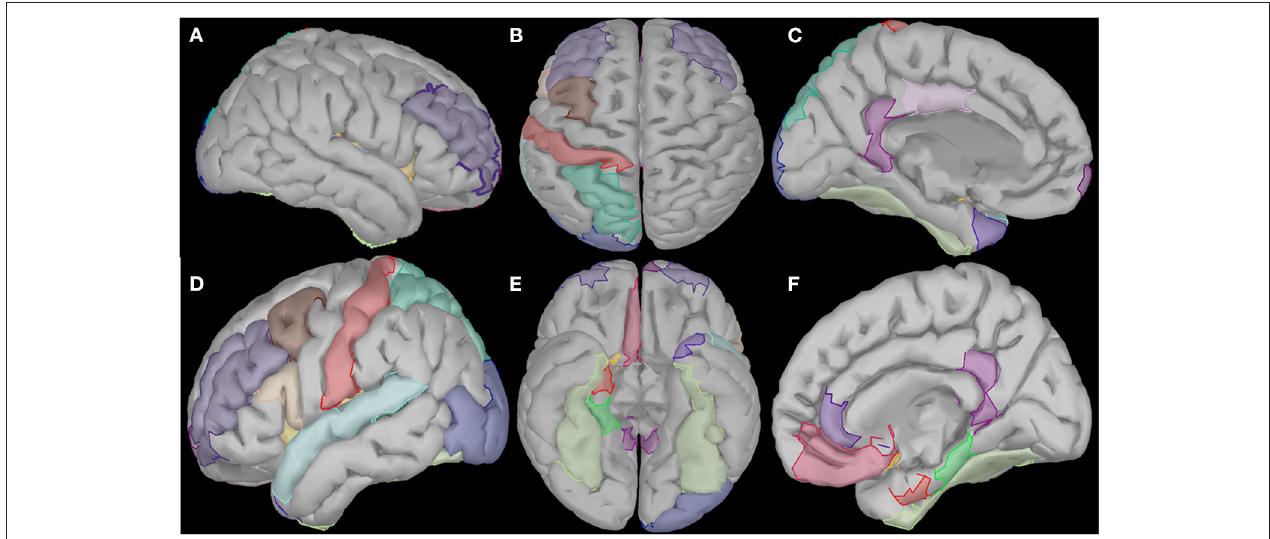
FIGURE 6 | Visualization of the cortical regions that changed linearly (either increased or decreased) from the beginning to the end of the intervention period for all frequency bands (delta, theta, alpha, beta and gamma). These regions diffuse in several cortical and subcortical areas such as right prefrontal and temporal areas (A) , central and posterior areas (B) , temporal and subcortical areas of the left hemisphere (C) , prefrontal, temporal and occipital areas of the right hemisphere (D) , and several subcortical areas of both hemispheres (E,F) .